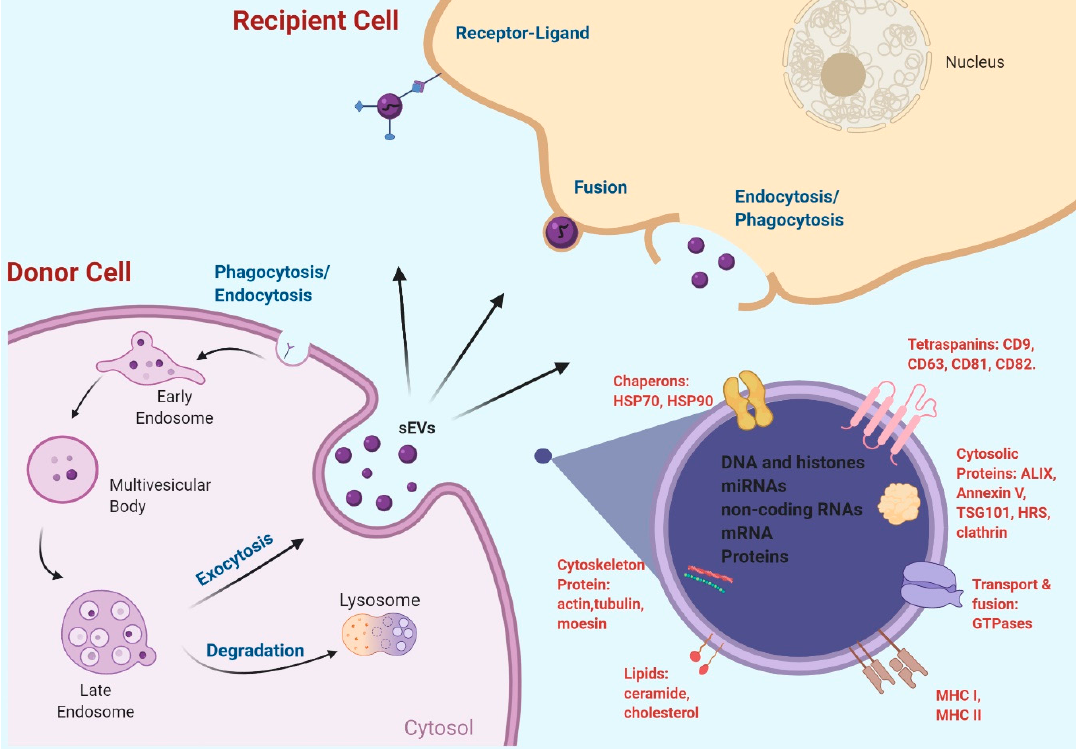
Figure 1. sEV biogenesis, release, uptake, and contents. Created with BioRender.com